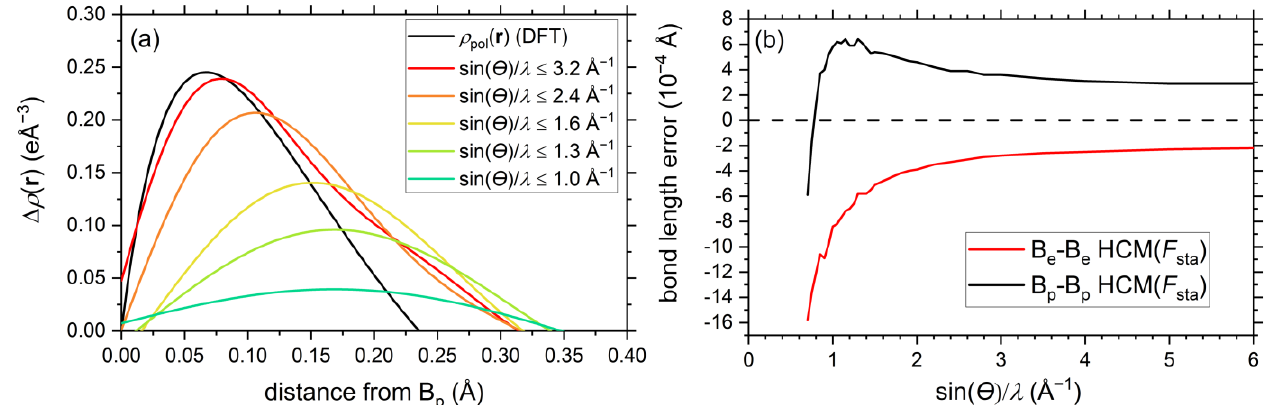
Figure 5. ( a ) EHCM(sph) residual electron density in the proximity of the B p atom along the direction opposite to the intericosahedral B p -B p -bond as a function of the resolution sin( ϴ )/ λ . The dipolar contribution ρ pol ( r ) to the electron density from DFT calculations is shown as a reference and its definition is given in Appendix B. ( b ) Resolution dependence of core asphericity shifts of the exo -B p -B p - and exo -B e -B e -bond in refinements of an HCM (with free scale and U iso parameters). A horizontal dashed line has been drawn at a value of zero, where the atomic positions correspond to the values used in the DFT calculations.